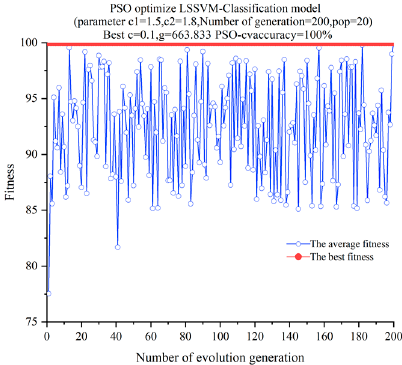
Figure 10. PSO–LSSVM fitness curve.